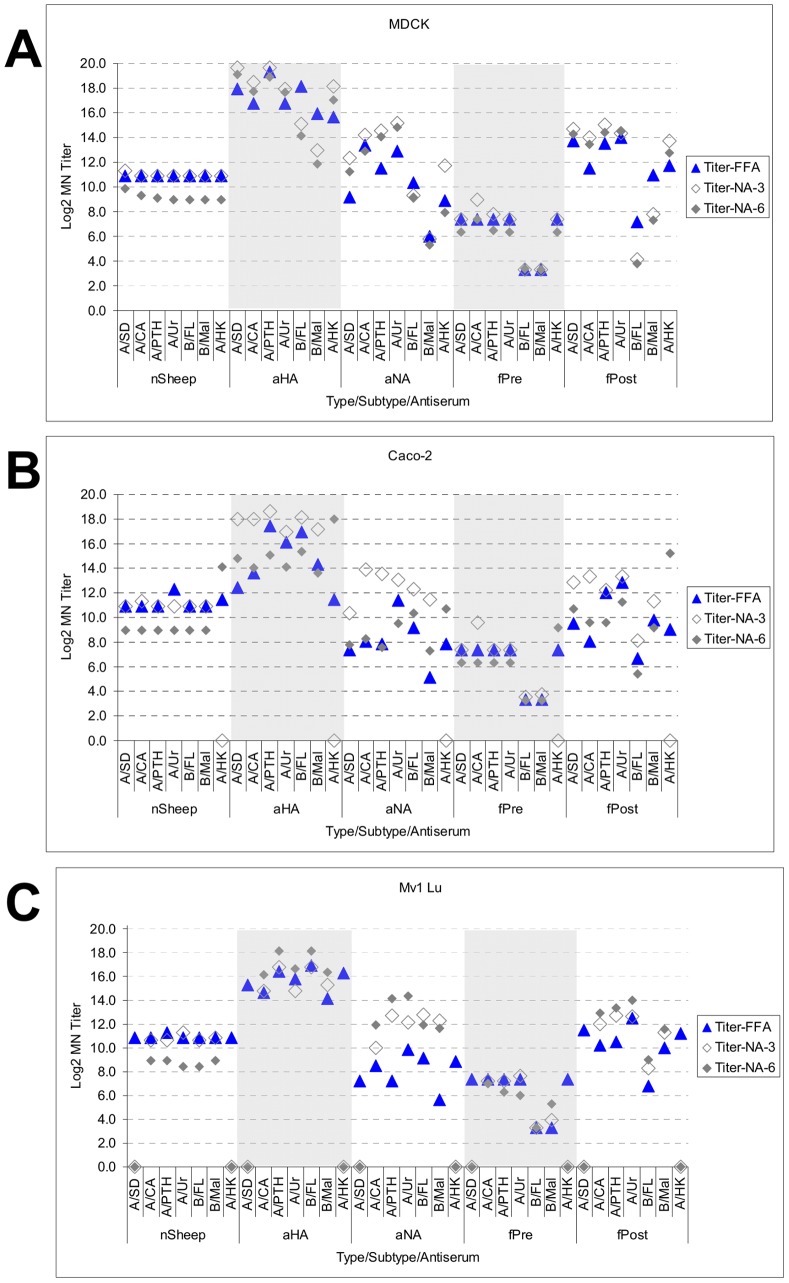
Neutralization of seven different influenza virus types and subtypes in MDCK, Caco-2, and Mv1 Lu cells (by cell line).Approximately 100 FFU of each virus type/subtype (see Materials and Methods for virus nomenclature) was added to serial 2-fold dilution of normal sheep antiserum (nSheep), sheep anti-HA (aHA), sheep anti-NA (aNA), or ferret polyclonal antiserum (pre- [fPre] or post-immunization [fPost] with the specified virus strain) and incubated at room temperature for 30 min. The serum treated virus was transferred onto MDCK (panel A), Caco-2 (panel B) and Mv1 Lu (panel C) cells. Neutralization titers were determined by FFA on Day 1 (blue solid diamonds, Titer-FFA) and NA activity on Day 3 (grey open diamonds; Titer-NA-3) and Day 6 (solid grey diamonds; Titer-NA-6). Titers were determined based on the log2 dilution that reduced the foci number or NA activity greater than or equal to 50% of that observed in virus control wells. Titers at the baseline (0.0) represent non-reportable titers, as virus growth was insufficient to make an estimate. The Day 1 and Day 3 titers are the average of 3 assays and the Day 6 titers are the average of 6 assays. The nSheep serum had a titer of <6.3 when assayed with minimal dilution. The titer reported in this chart is higher due to the starting dilution used in assays that was identical to the dilution used for the hyperimmune anti-HA antisera.